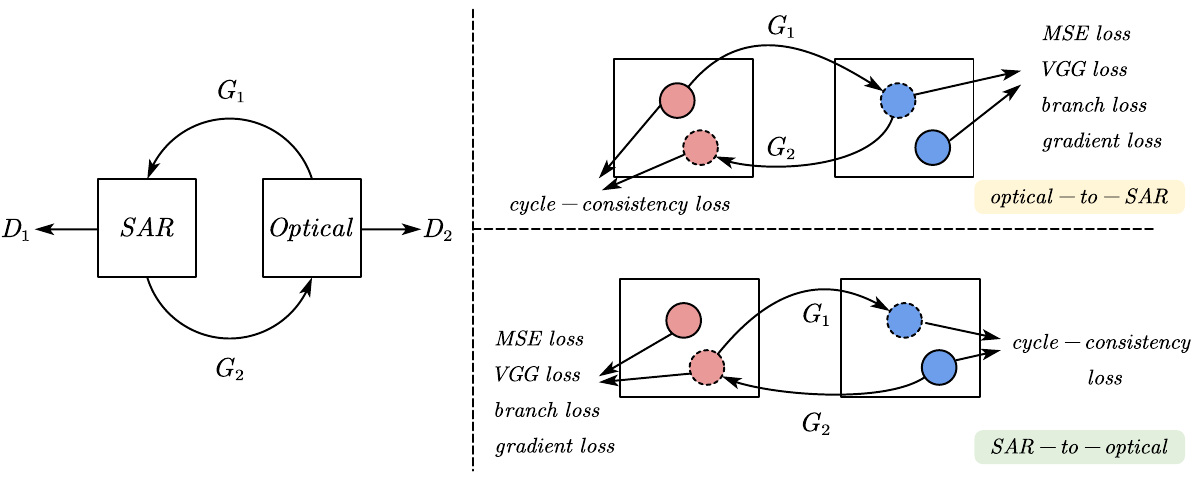
Figure 3. Our framework is based on the CycleGAN model. We added the loss of mean square error and other losses in the mapping between the SAR image and optical image to achieve better